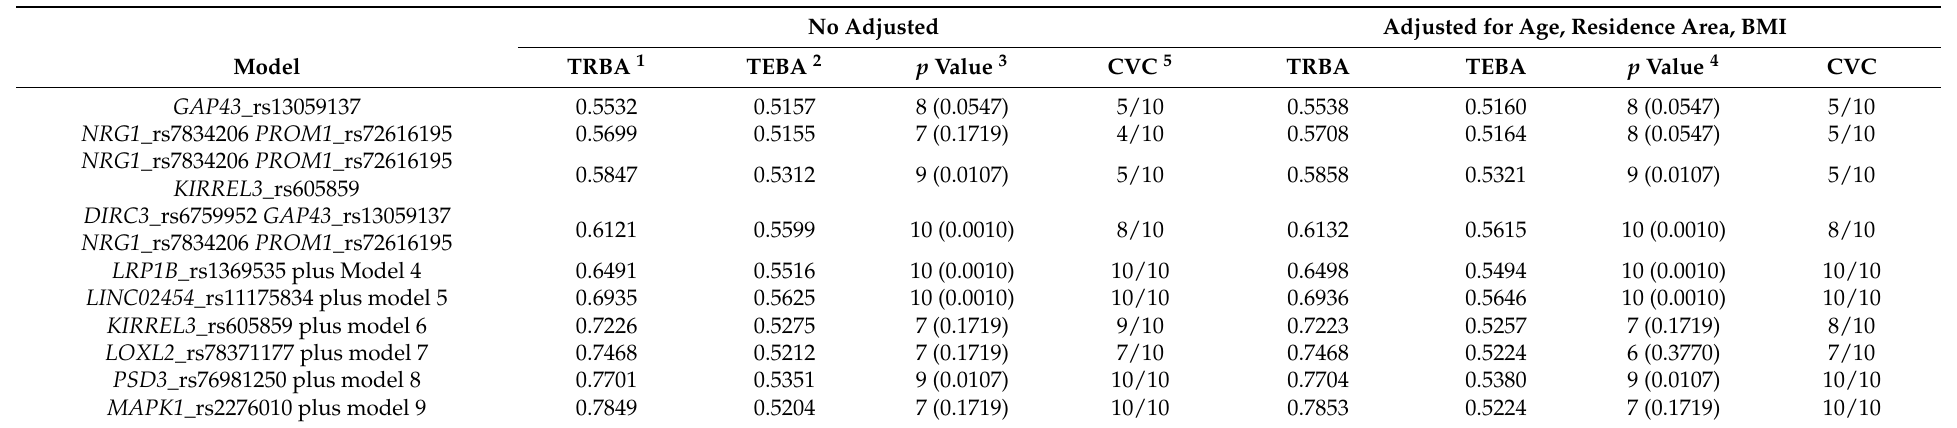
Table 4. Generalized multifactor dimensionality reduction (GMDR) results of SNP–SNP interaction in the multi-locus of the genes in thyroid